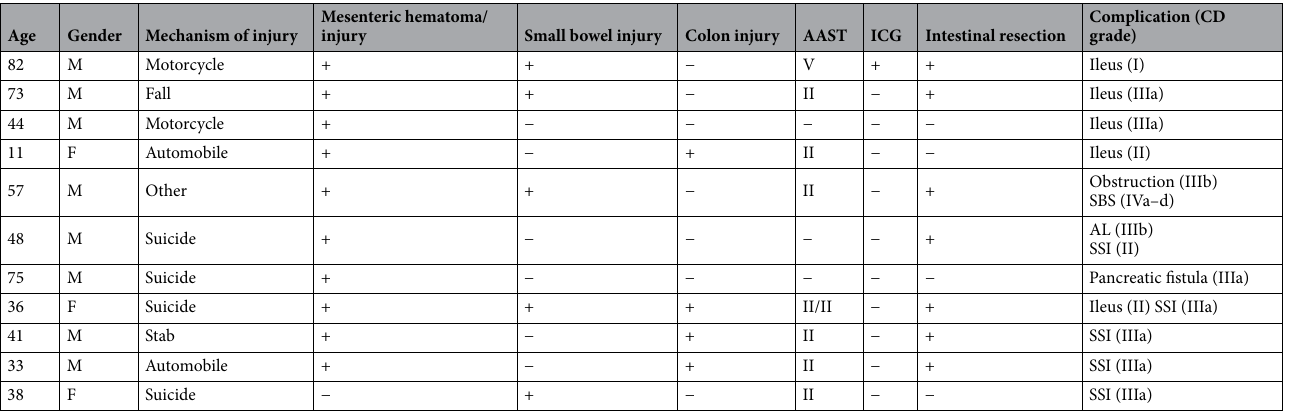
Table 3. The postoperative complications of each